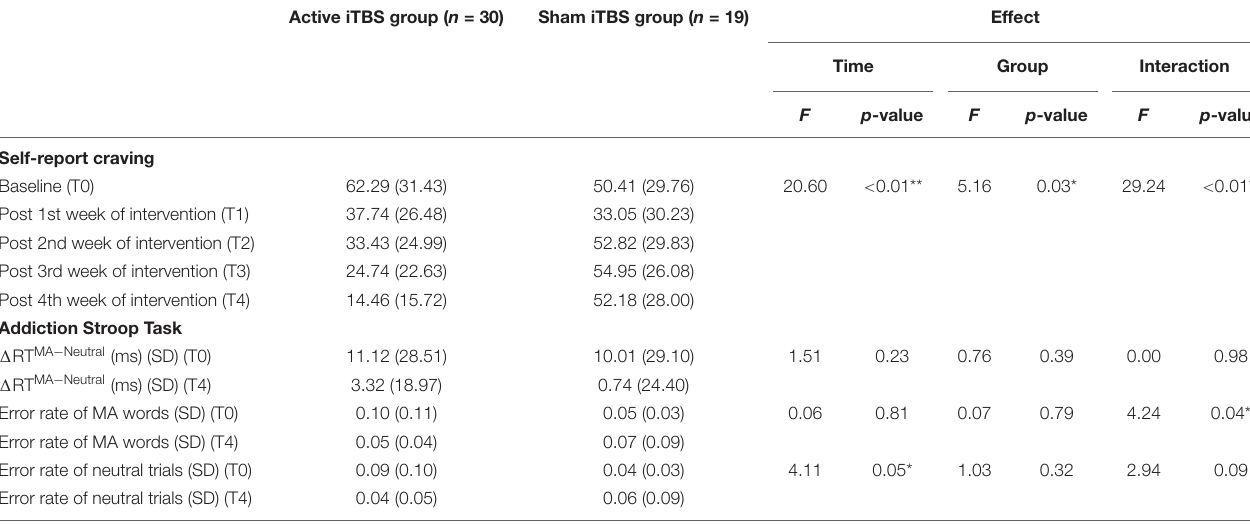
TABLE 2 | Craving and Addiction Stroop Task performance of patients after DLPFC iTBS intervention. Active iTBS group ( n = 30) Sham iTBS group ( n = 19) Effect Time Group